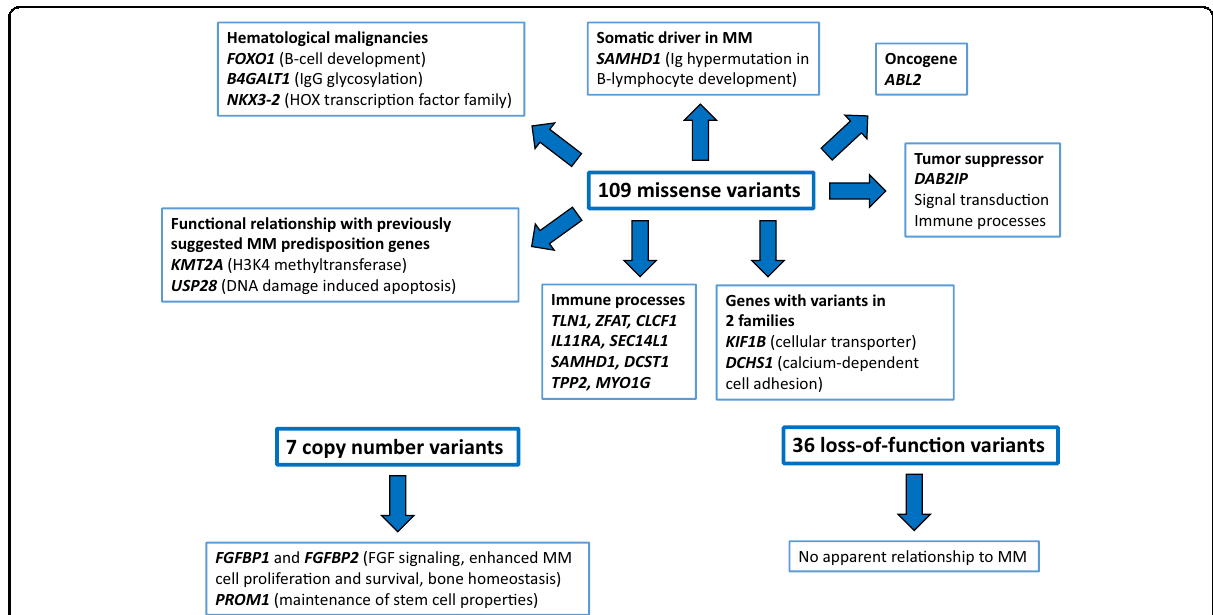
Fig. 2 Summary of the identi fi ed variants in the multiple myeloma families. Total number of missense, loss-of-function, and copy-number variants are shown, and for the most intersting variants the function of the corresponding